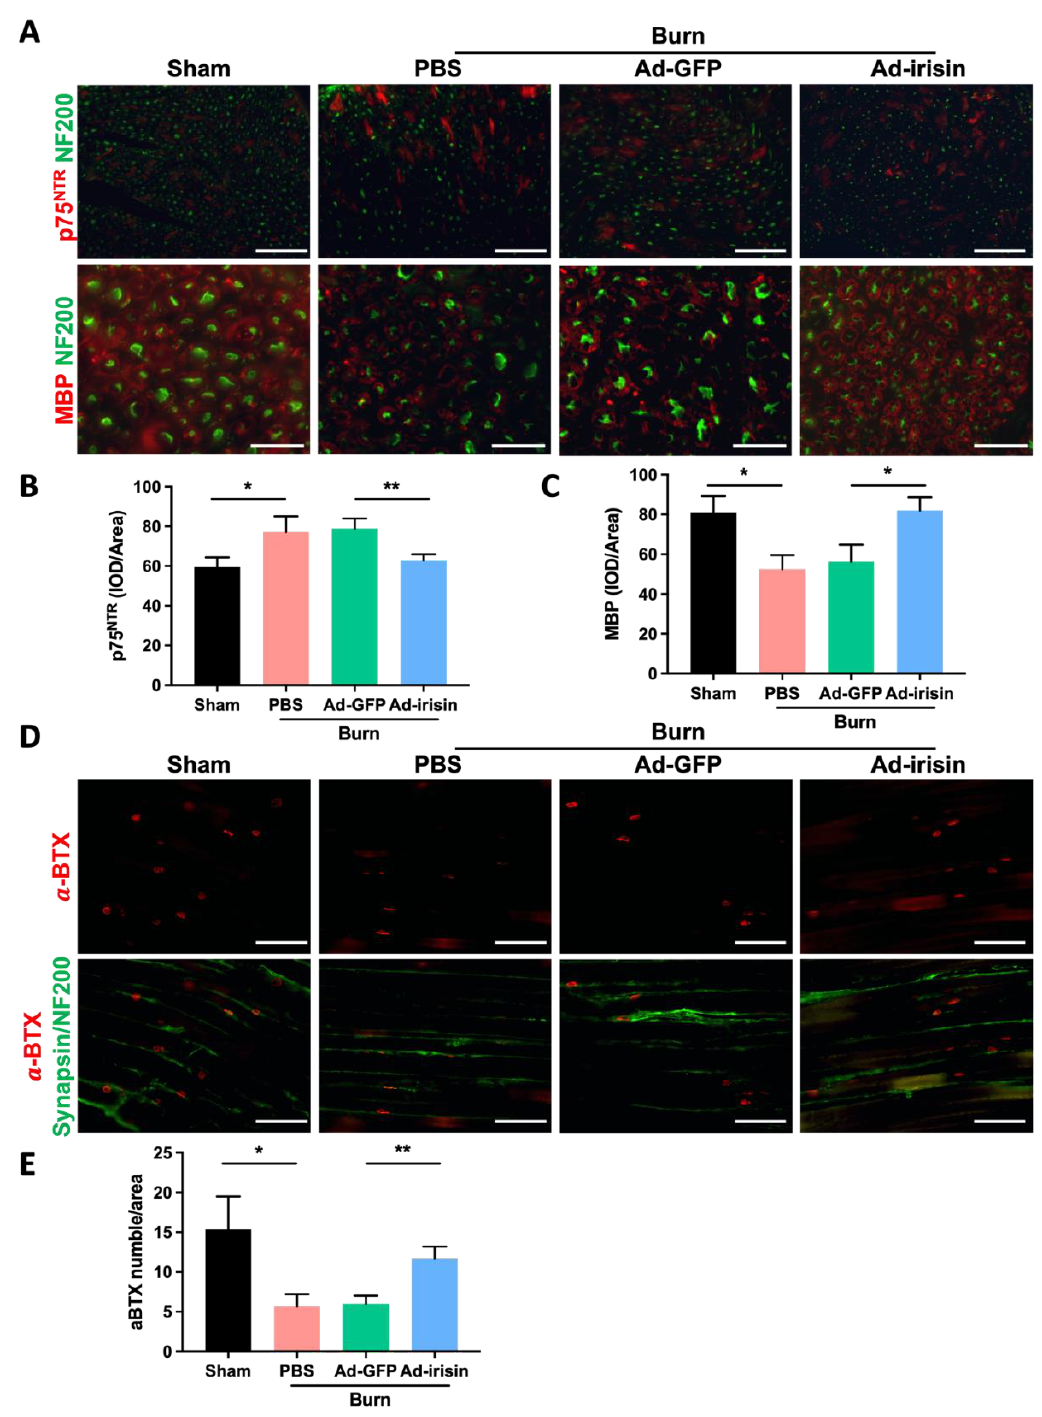
Figure 4. Spinal irisin gene delivery attenuated burn injury-induced demyelination in the sciatic nerve and decreased innervation of neuromuscular junction. ( A ) Immunofluorescence staining of p75NTR and MBP in the sciatic nerve in the fourth week after burn injury. NF200 stain was used to visualize neurofilaments. ( B , C ) Representative bar graphs illustrating averaged optical intensity of p75NTR and MBP. Error bars represent standard deviations (SDs). * p < 0.05, ** p < 0.01, unpaired t -test. ( D ) Immunofluorescence staining of α -BTX in ipsilateral gastrocnemius muscle in the fourth week after burn injury. Synapsin and NF200 staining was used to visualize neurofilaments. ( E ) Representative bar graph illustrating the number of α -BTX-positive areas. Error bars represent SDs. * p < 0.05, ** p < 0.01, unpaired t